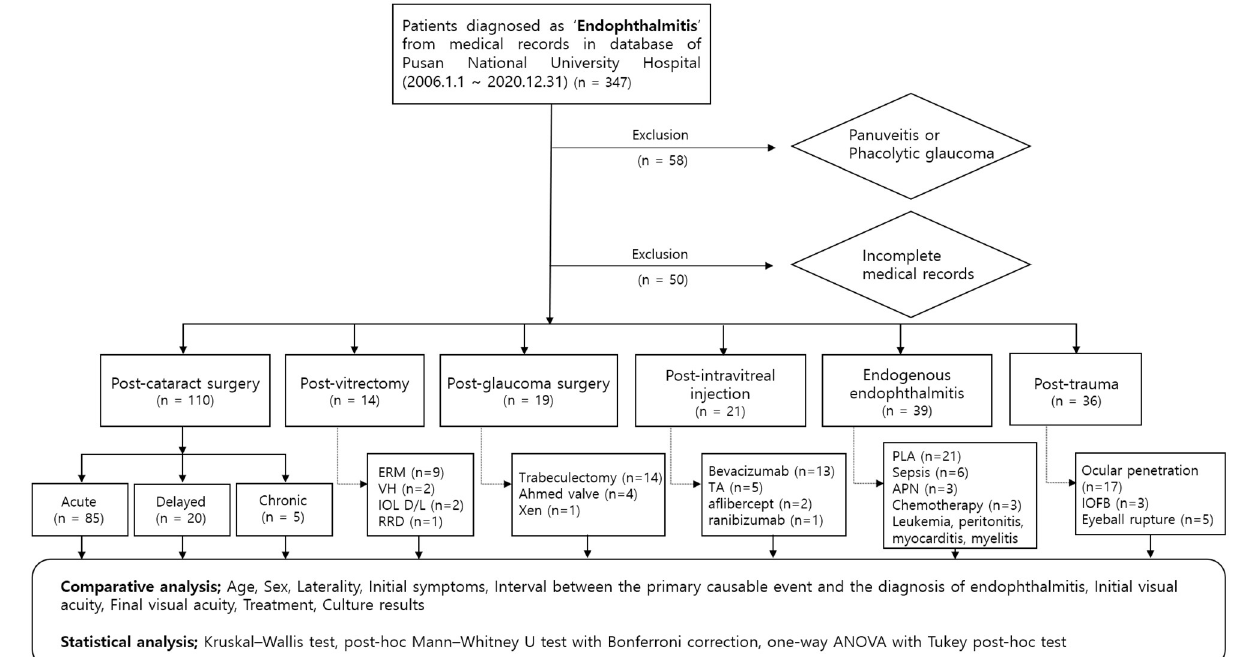
Fig 1. Flow chart of endophthalmitis classification according to etiology. (APN: acute pyelonephritis, ERM: epiretinal membrane, IOFB: intraocular foreign body, IOL D/L: intraocular lens dislocation. PLA: pyogenic liver abscess, RRD: rhegmatogenous retinal detachment, TA: triamcinolone acetonide, and VH: vitreous hemorrhage).